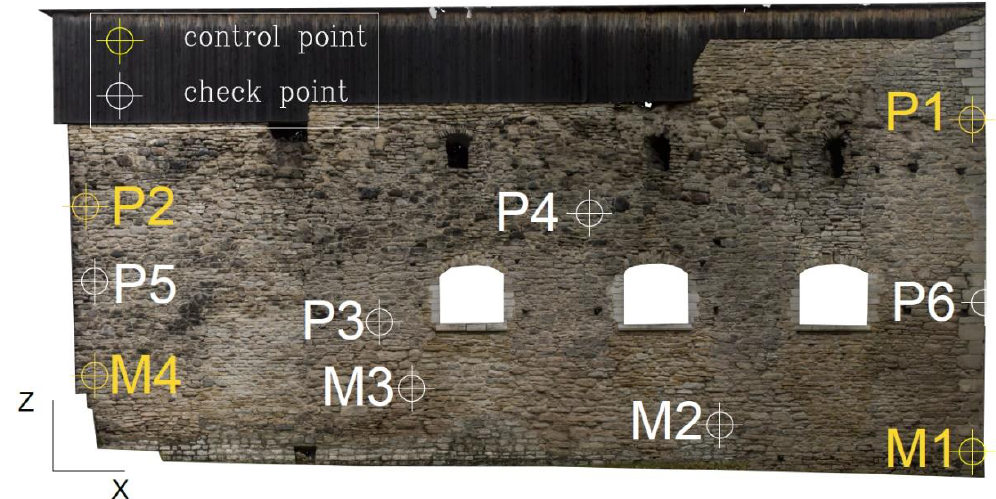
Figure 7. Distribution of control points (yellow) and check points (white). Table 4. Di ff erences on control and check points between measured coordinates from re-processing and adjusted coordinates from new